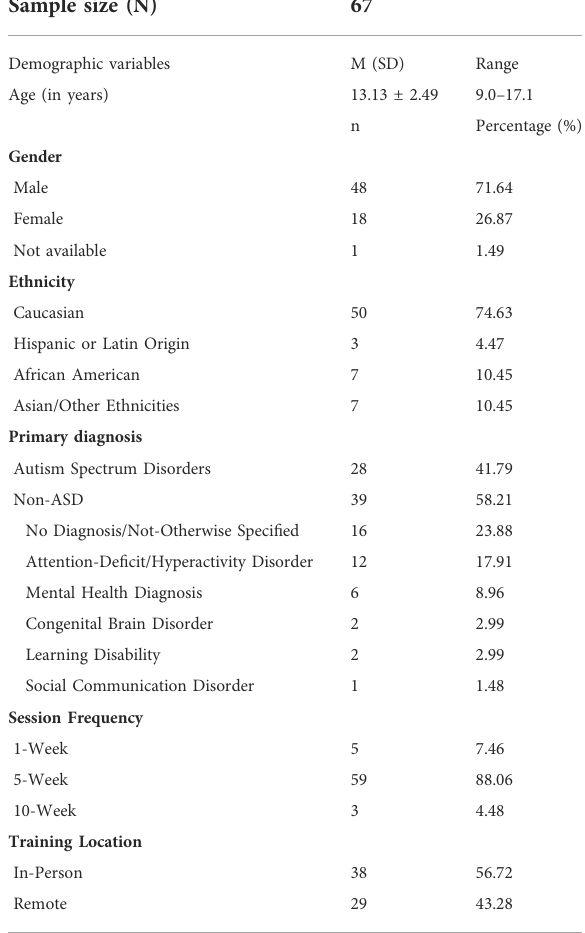
TABLE 1 Demographic characteristics of pediatric participants in the present